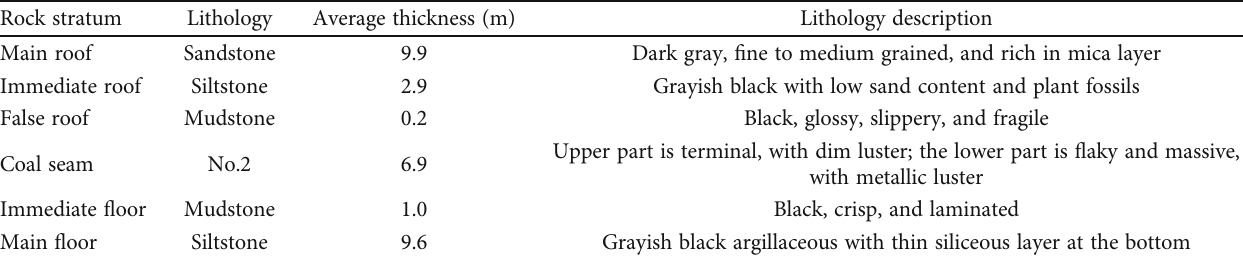
Table 2: Geological description of the coal seam roof and fl